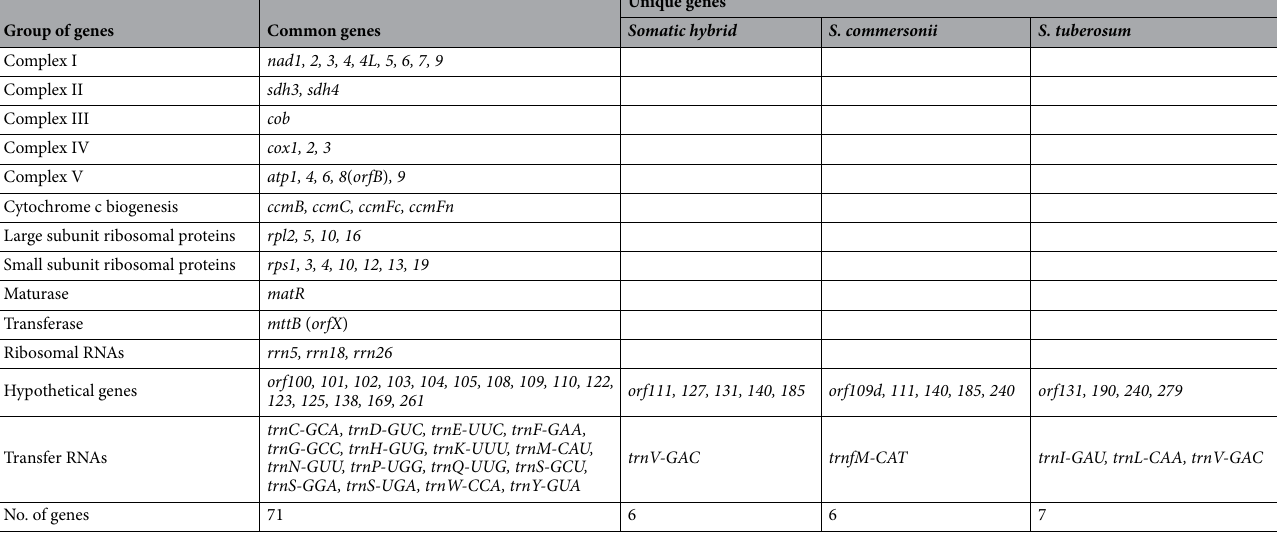
Table 2. Common and unique mitogenome genes of a somatic hybrid and its parent